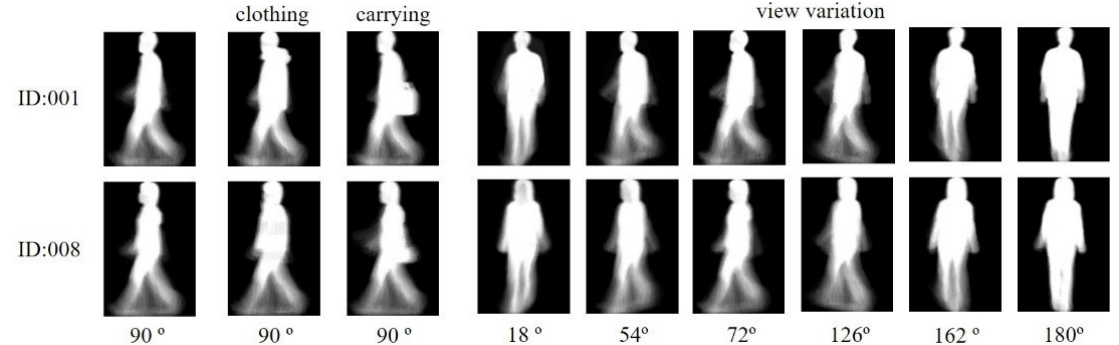
Figure 1: Example GEIs of two persons in CASIA-B gait dataset [30]. The leftmost column is the GEIs under viewing angle 90 in normal condition, while the rest are GEIs with covariates such as clothing, carrying and view.